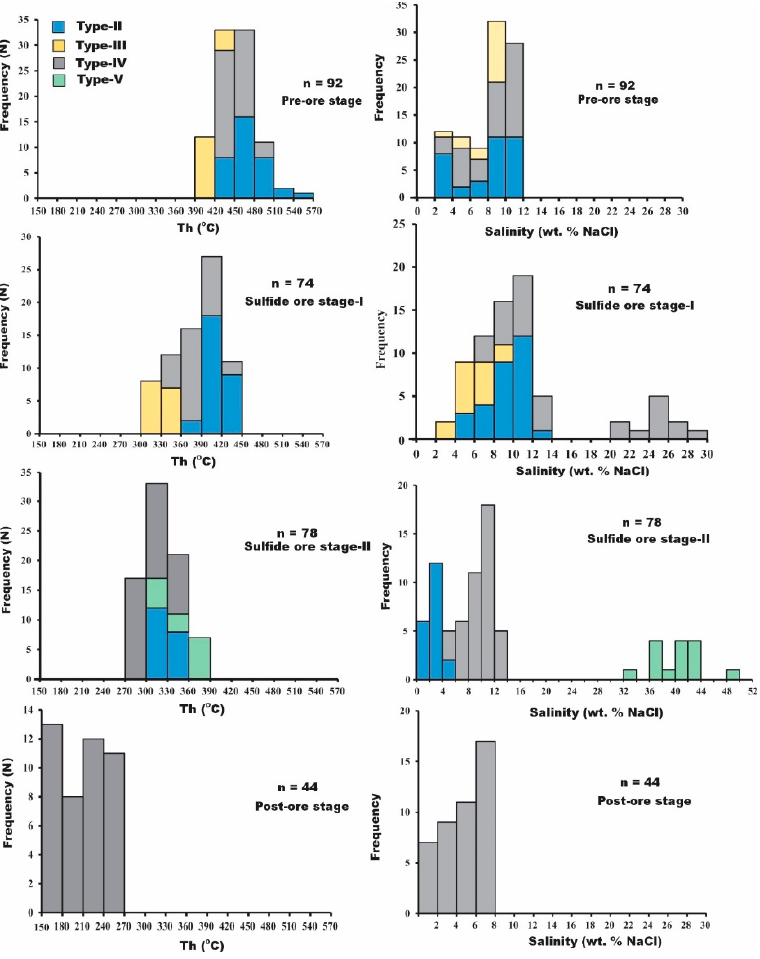
Figure 8. Histograms of homogenization temperatures (T h ) and salinities of fluid inclusions of the different mineralization stages.